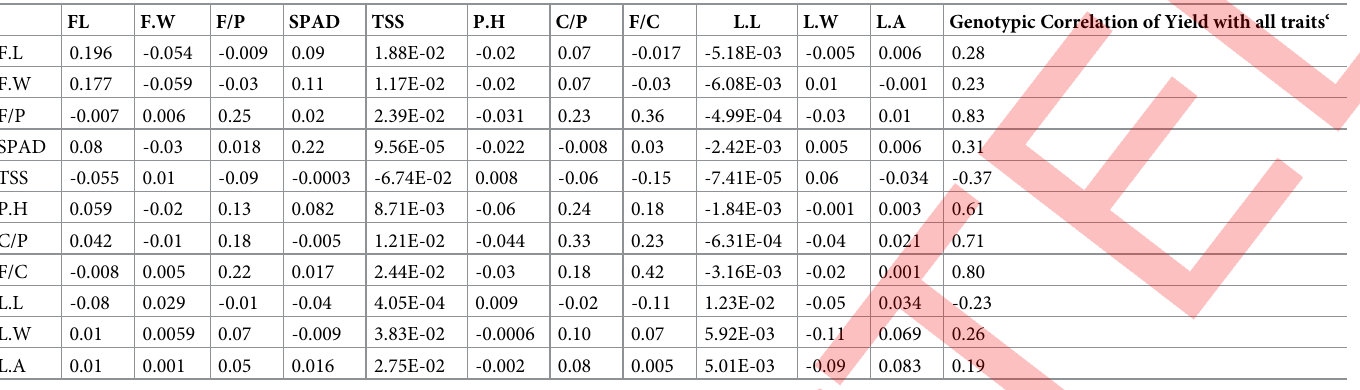
Table 6. Direct and indirect effects of different traits on yield derived from path coefficient analysis.